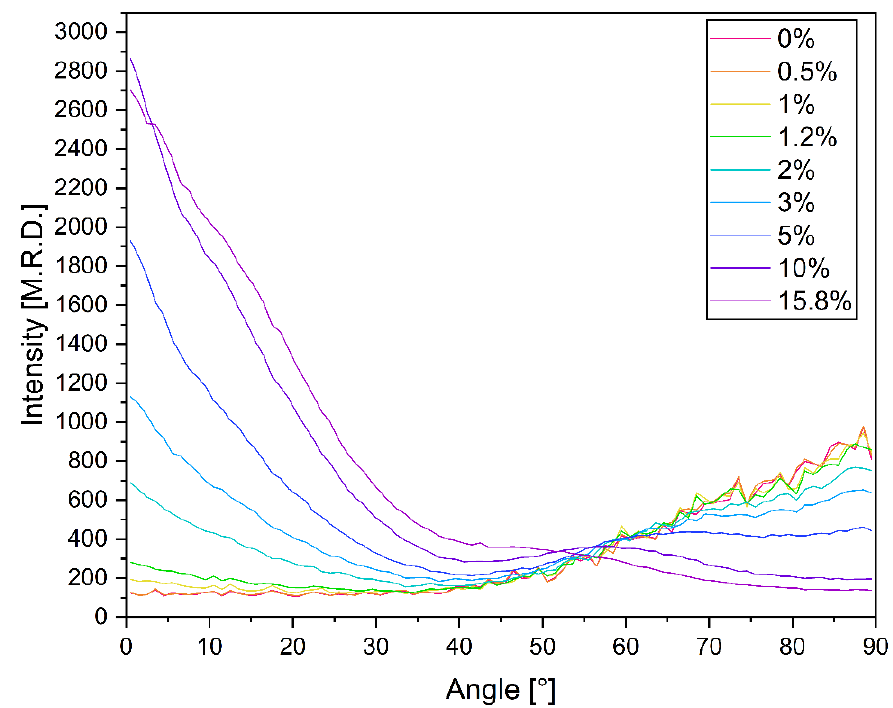
Figure 8. The azimuthal distribution function at different strains for AZ91 as extruded. The units of intensity are multiples of random distribution. Table 5 . TVF of the matrix at failure strain.